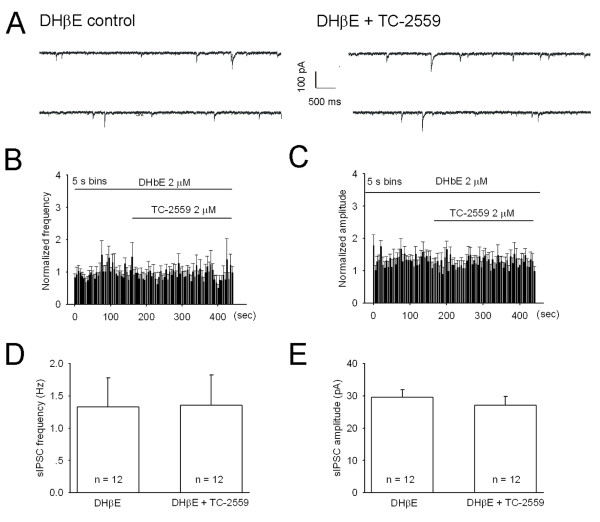
TC-2559 enhances sIPSCs by activation of α4β2 subtype of nAchRs. A, Sample traces of sIPSCs recorded from a lamina II neuron in the presence of 15 μM DNQX and 2 μM DHβE before (left) and during bath application of 2 μM TC-2559 (right). Membrane potential was clamped at -70 mV. B-C, Normalized rate histogram showing the sIPSC frequency (B) and amplitude (C) before and during bath application of 2 μM TC-2559 in the presence of 2 μM DHβE (n = 12). D-E, In the presence of 2 μM DHβE, 2 μM TC-2559 had no significant effects on both the frequency (D, P = 0.6865, n = 12) and amplitude (E, P = 0.0978, n = 12) of sIPSCs (Paired t test).